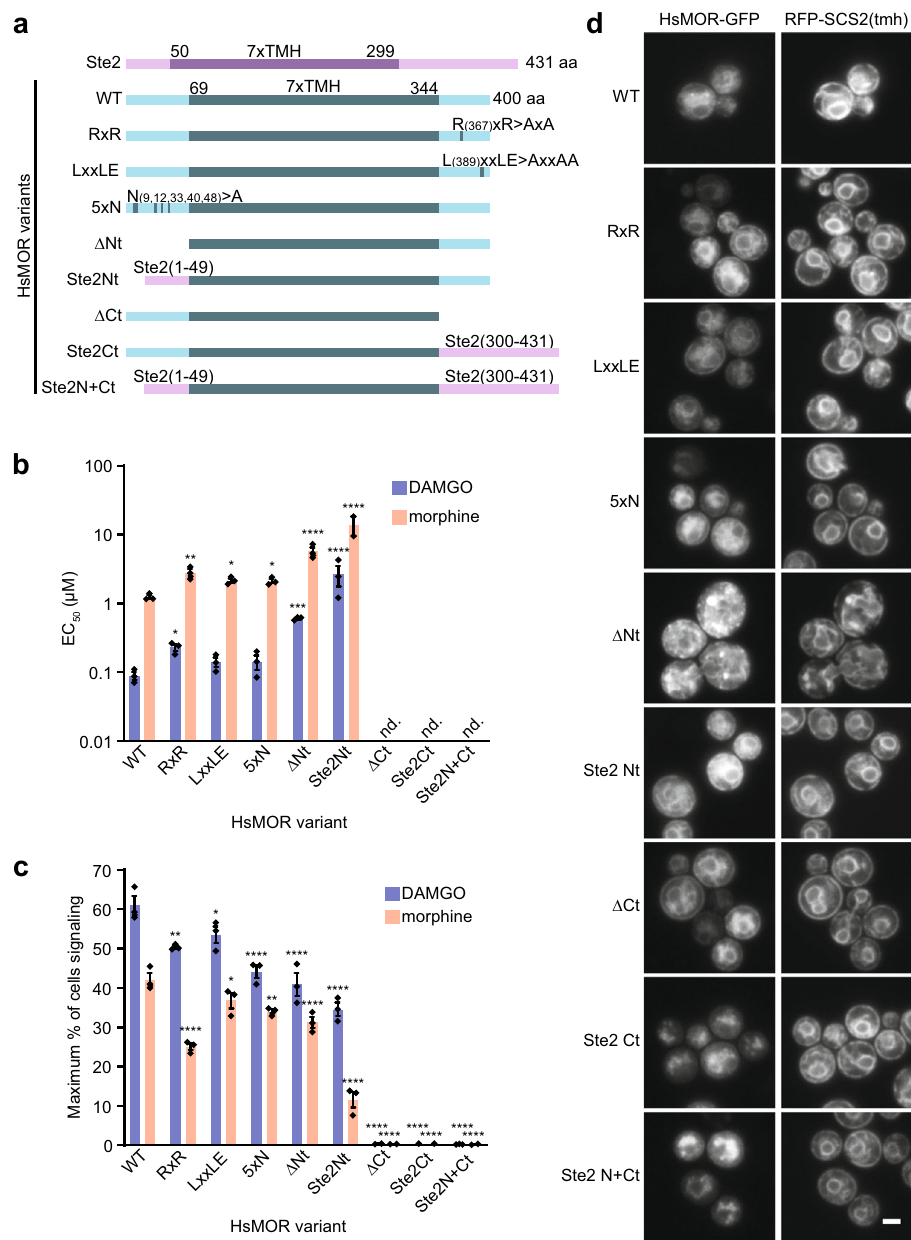
Fig. 5 The functional requirements of HsMOR N- and C-terminal domains on biosensor activity. a Domains of Ste2, HsMOR, and HsMOR variants with the highly conserved seven transmembrane helix (7xTMH) domains indicated. b DAMGO and morphine sensitivity of biosensors based on the indicated HsMOR variants. Unpaired one-way ANOVA of pEC 50 s: n = 3 biologically independent experiments, >7464 cells/strain/replicate; P < 0.0001 for both agonists; Dunnett ’ s tests against WT shown. c The effect of N- and C-terminal HsMOR mutations on the population of signaling biosensor cells. Unpaired one-way ANOVA: n = 3 biologically independent experiments, >7464 cells/strain/replicate; P < 0.0001 for both agonists; Dunnett ’ s tests against WT shown. d Imaging of C-terminally GFP-tagged HsMOR variants in a cholesterol-producing background with ER marker RFP-SCS2(tmh). n = 3 biologically independent experiments. Data presented as mean + / − SEM. Scale bar is 2 μ m. *, P < 0.05; **, P < 0.01; ***, P < 0.001; ****, P < 0.0001. Source data are provided as a Source Data fi showed no activity while maintaining nearly wild type localiza- tion, though with increased vacuolar pools (Fig. 5b – d). The failure of the C-terminal mutants to signal was unexpected as a similar C-terminal deletion displayed only a small reduction in DAMGO sensitivity when expressed in CHO cells 61 . While this may indicate more stringent requirements for activity in yeast, the C-terminal deletions used here disrupt the short cytosolic helix (helix 8) next to the transmembrane domain that, while not involved directly in G protein binding or signal transduction, may